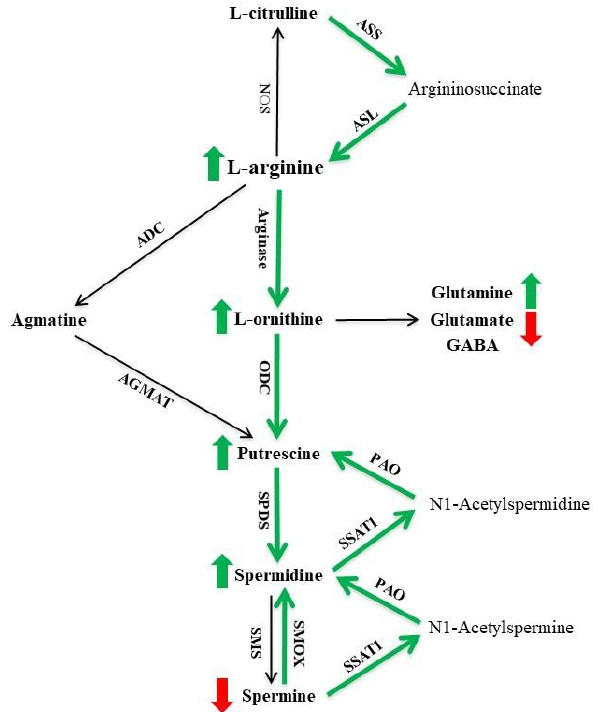
Figure 1. L-arginine metabolic pathways and the polyamine system. L-arginine is metabolized by nitric oxide synthase (NOS), arginase and arginine decarboxylase (ADC) to form several bioactive molecules and can be de novo synthesized by argininosuccinate synthetase (ASS) and argininosuccinate lyase (ASL) from L-citrulline (see text for detailed description). Overall, we found genotype- and age-related increases in L-arginine, L-ornithine, glutamine, putrescine and spermidine (indicated by short green arrows) and decreases in glutamate and spermine (indicated by short red arrows) levels in the brain of PS19 mice, indicating a shift of L-arginine metabolism towards the arginase and polyamine system. Moreover, PS19 mice displayed increased levels of mRNA and/or protein expres- sion of ASS, ASL, arginase I and II, ornithine decarboxylase (ODC), spermidine synthase (SPDS), spermine oxidase (SMOX), spermidine/spermine-N 1 -acetyltransferase-1 (SSAT1) and polyamine oxidase (PAO), suggesting upregulated citrulline recycling and polyamine retro-conversion (indicated by long green arrows). AGMAT, agmatinase; SMS, spermine synthase. Adapted from